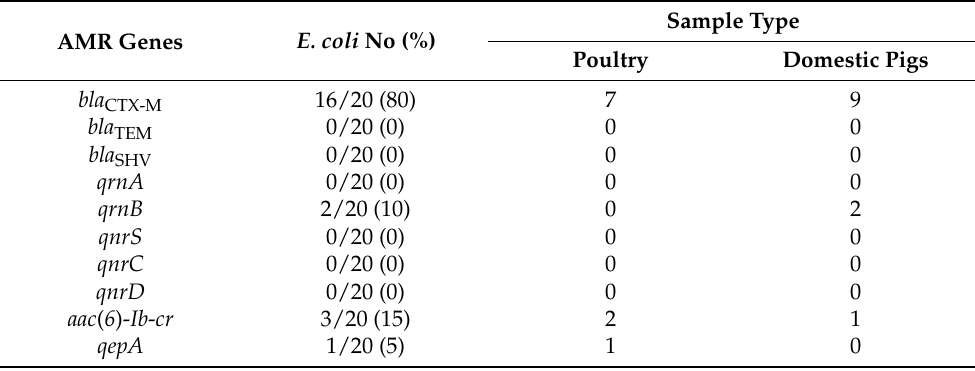
Table 9. Distribution of ESBL and quinolone-resistant genes from the selected multidrug-resistant (MDR) E. coli ( n =